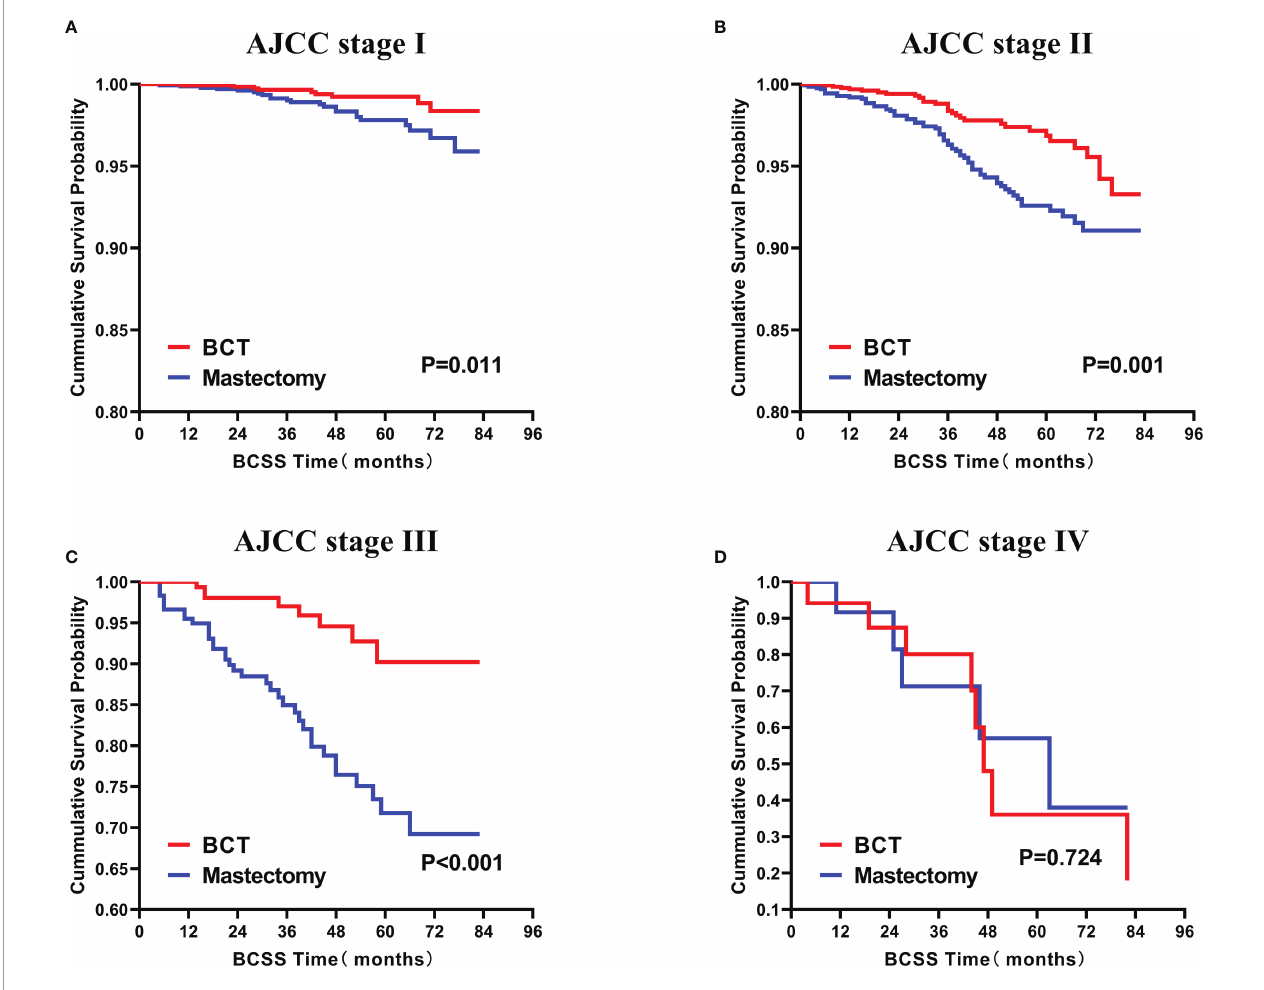
FIGURE 7 | Kaplan – Meier Curves for BCSS by treatment type for all patients, strati fi ed by AJCC stage: (A) AJCC stage I. (B) AJCC stage II. (C) AJCC stage III. (D) AJCC stage IV. BCSS, breast cancer speci fi c survival; BCT, breast-conserving